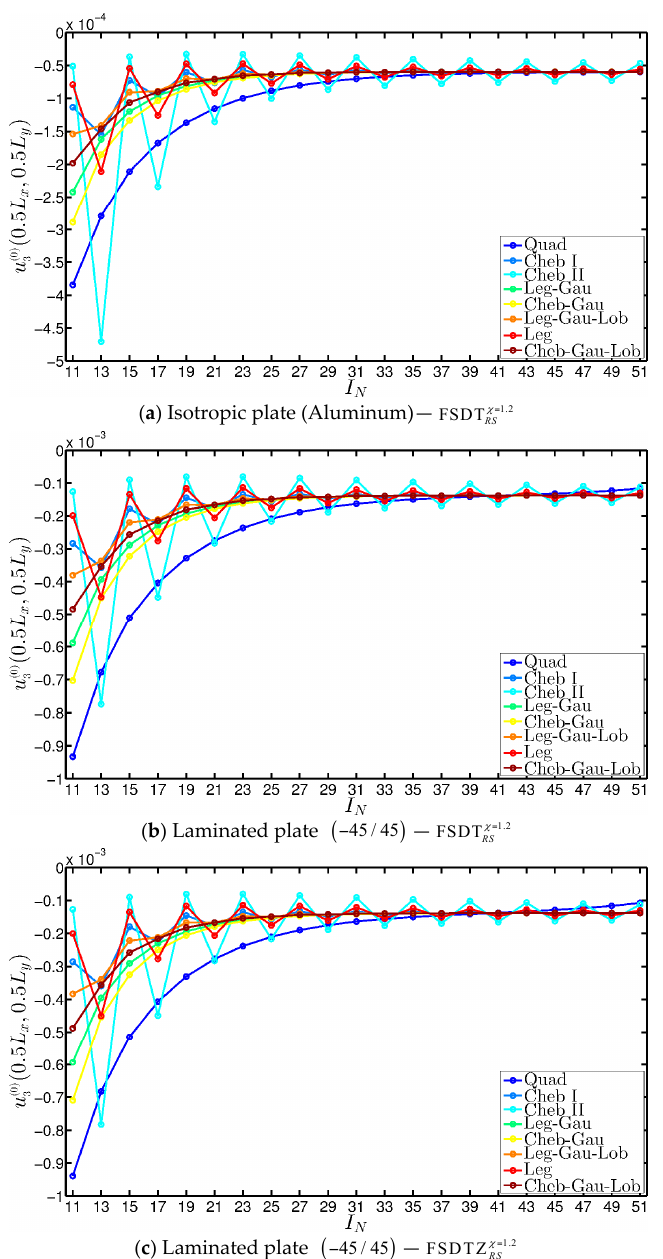
Figure 5. Convergence analysis in terms of central deflection [m] for the SSSS square plate increasing the number of grid points I N = I M for various grid distributions related to the GDQ method. Different mechanical configurations are considered: ( a ) Isotropic (Aluminum); ( b , c ) Laminated (Glass-Epoxy) with ( − 45/45 ) as stacking sequence. The laminated structure in (b,c) is investigated by means of the FSDT χ (case b) and the FSDTZ χ (case c). The same function Gau-1 is applied in each layer to model the damage features.